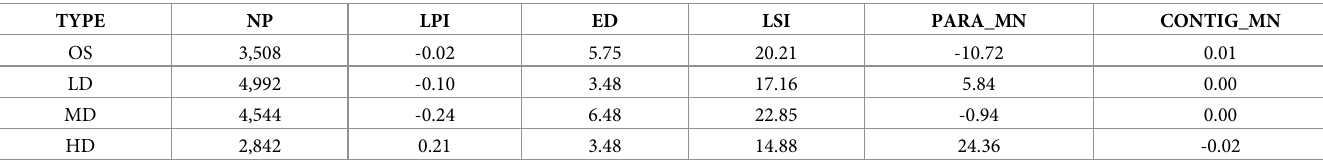
Table 5. Changes of Landscape metrics of urban densities in SEWI (2001–2011). TYPE